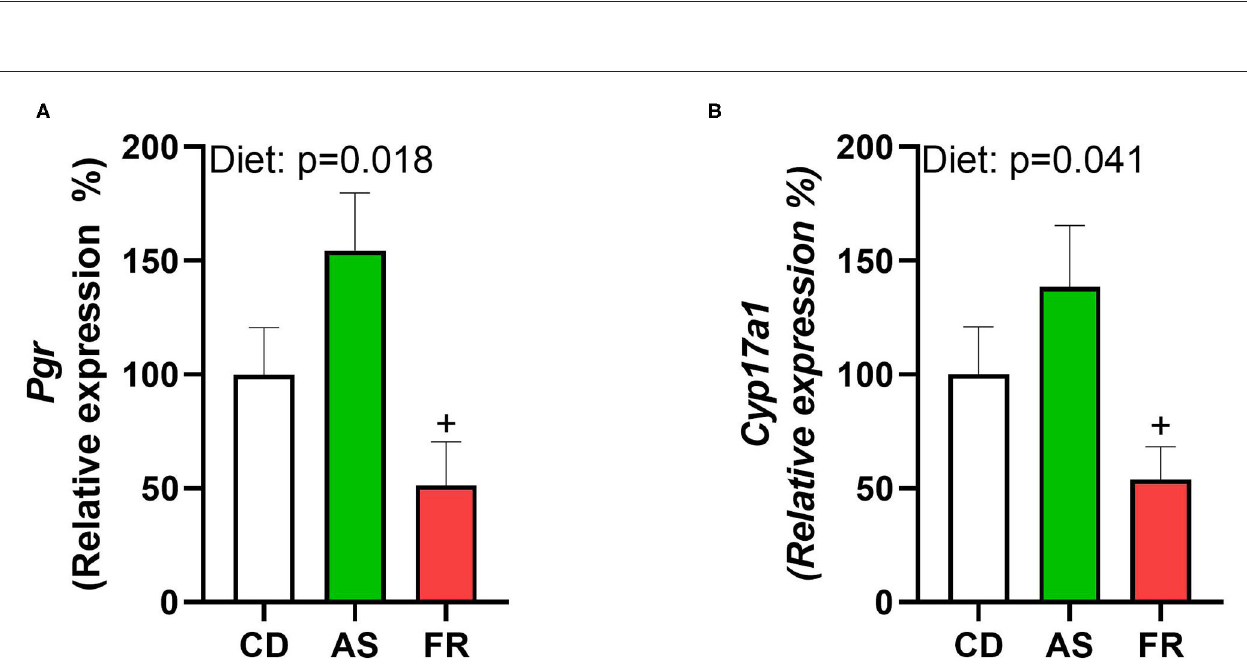
Frontiers in Nutrition |